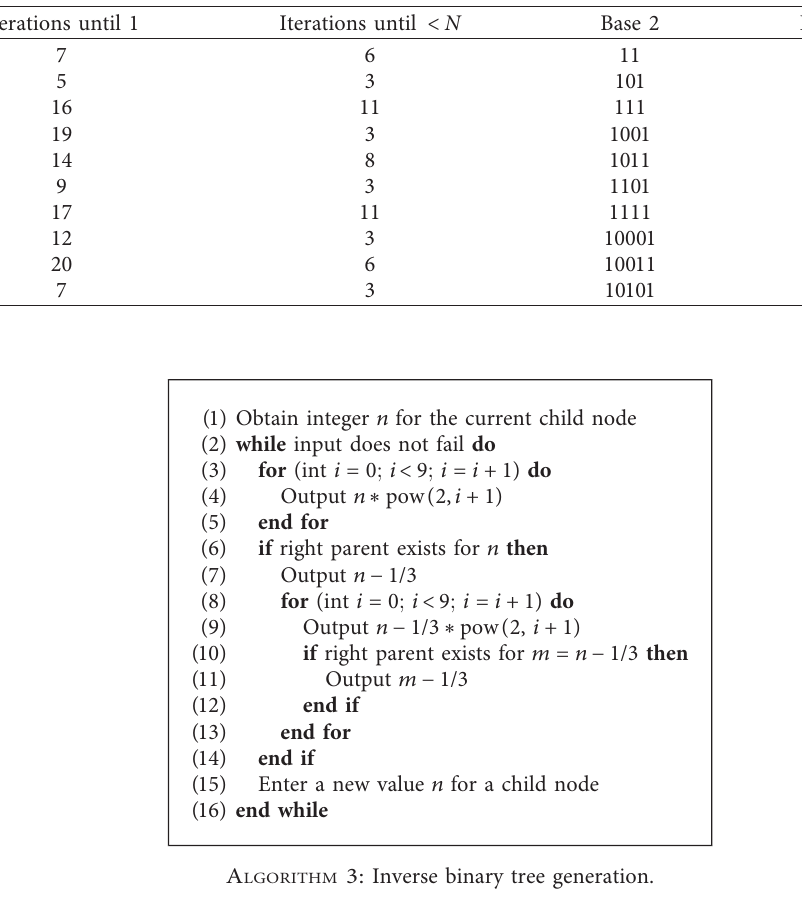
Table 4: Output from Algorithm